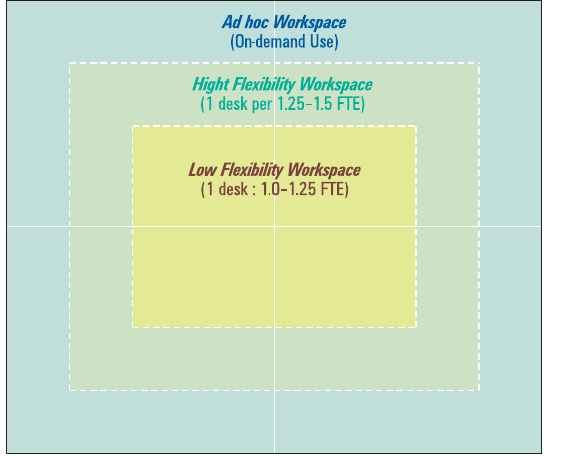
Figure 9. Adapted portfolio fl exibility model